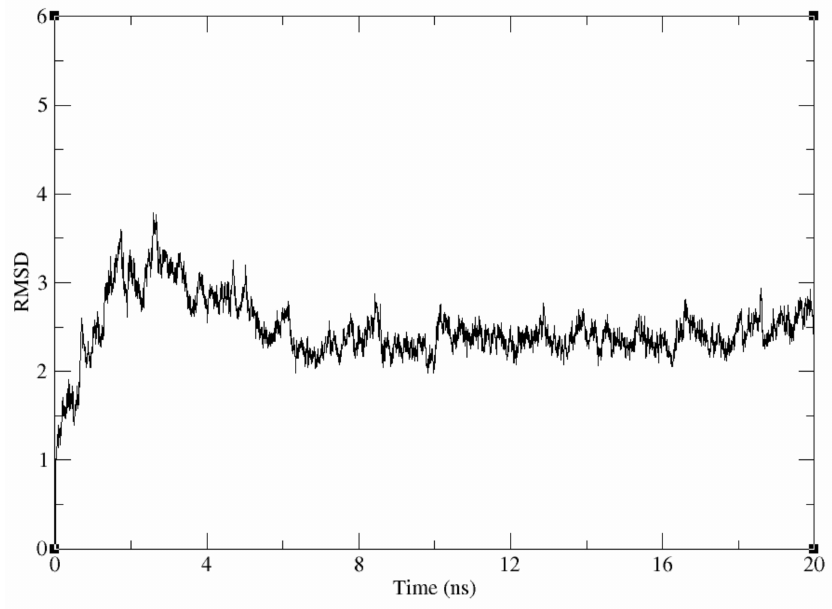
Figure 4. Root mean square deviation (rmsd) of generated homology sampled during 20ns molecular dynamics (MD) simulation with respect to the initial structure versus simulation